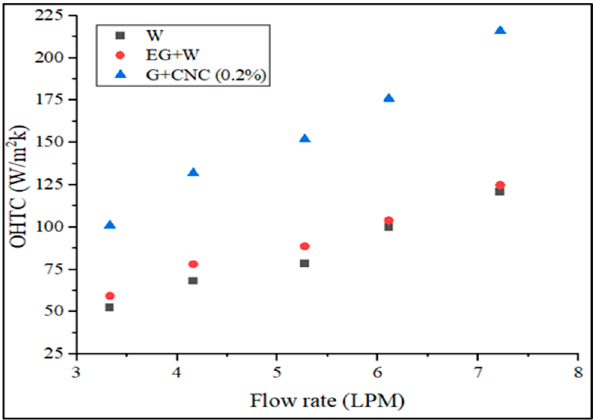
Figure 10. Overall heat transfer coefficient (OHTC) vs. flow rate in LPM.